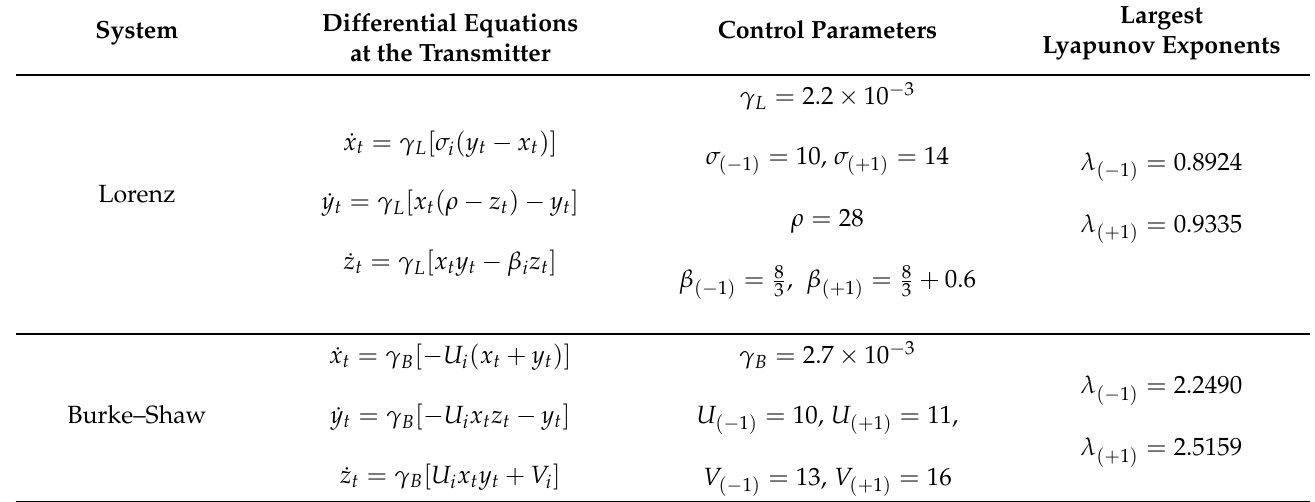
Table 1. Nonlinear differential equations governing the Lorenz [44] and Burke–Shaw [45] dissipative chaotic systems, their control parameter values, and corresponding Lyapunov